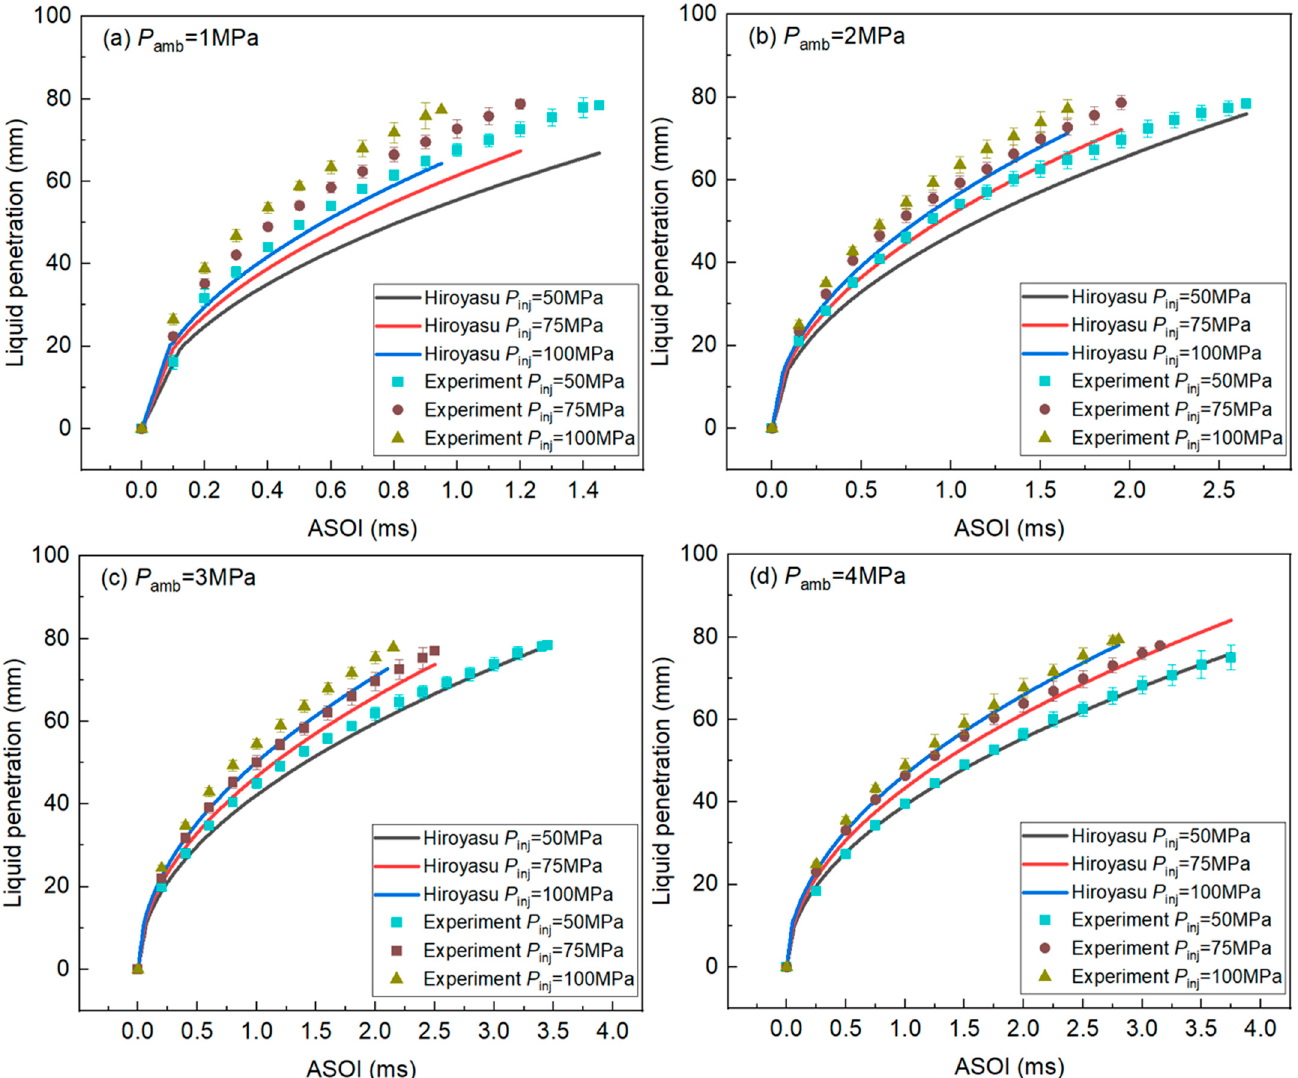
Figure 5. Liquid penetration in the modified Hiroyasu model prediction and experiments; fuel: liquid ammonia; ( a ) P amb = 1 MPa, ( b ) P amb = 2 MPa, ( c ) P amb = 3 MPa; ( d ) P amb = 4 MPa.